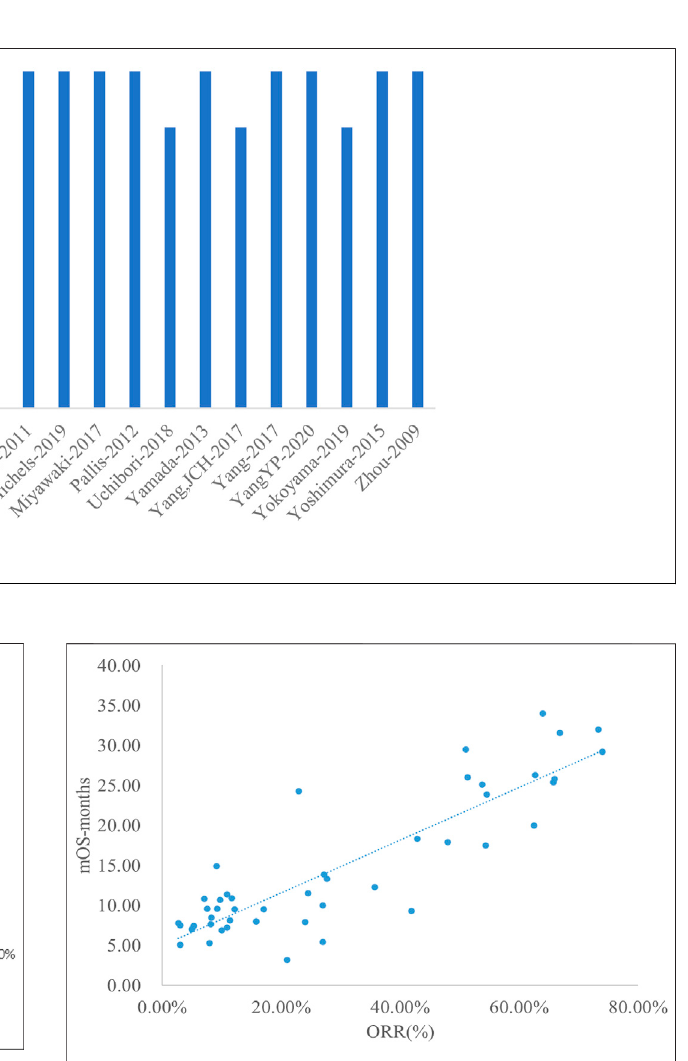
FIGURE 6 | Linear fi tting results for ORR and mOS.